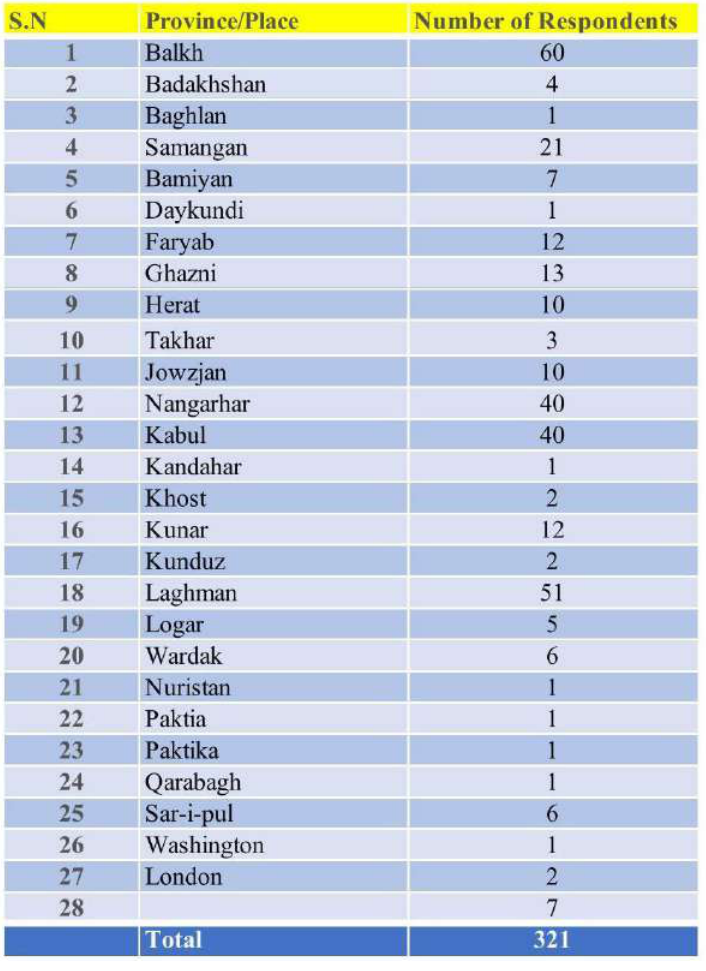
Table 1: Province-wide Distribution of Respondents (Source: Authors‟